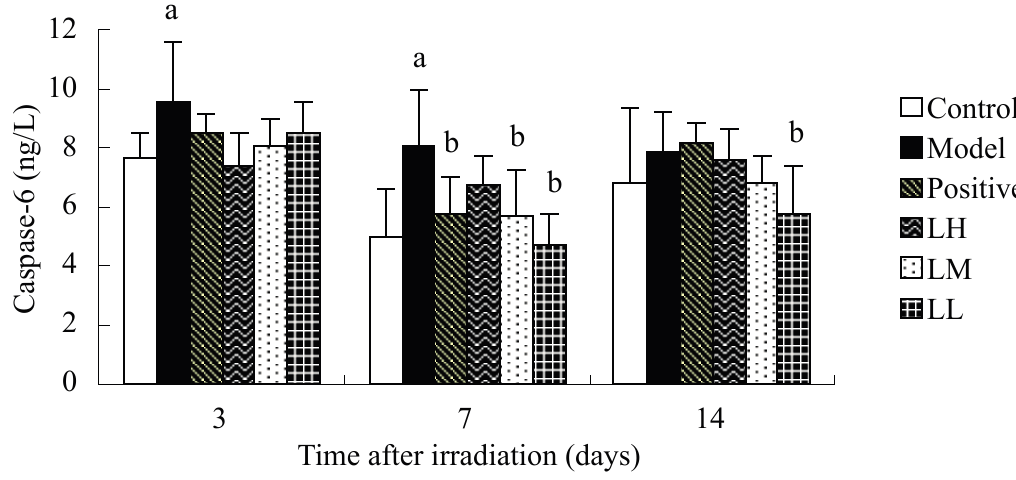
Figure 6. Effect of Lycium ruthenicum Murr. on the caspase-3 and caspase-6 of mice after radiation treatment. n = 10, mean ± SD. a p < 0.05 vs. control group, b p < 0.05 vs. model